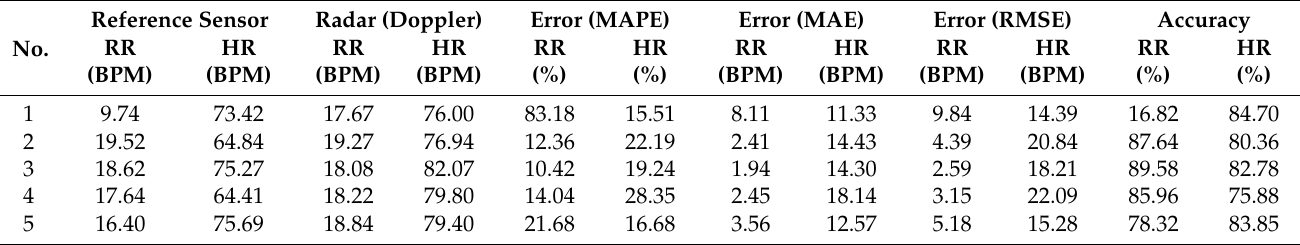
Table 3. The measurement accuracy of respiration and heartrates monitored by the Doppler radar for the case without interferer.